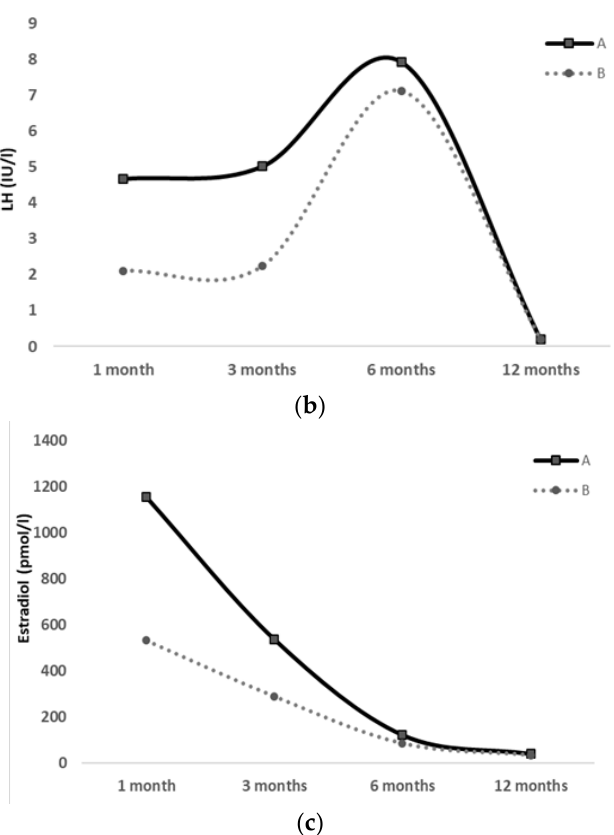
Figure 2. FSH ( a ), LH ( b ) and Estradiol ( c ) serum levels at 1, 3, 6 and 12 months of life in a pair of preterm twin girls; clinical pubertal signs were exhibited only by the first twin (twin A), whereas they were absent in the second twin (twin B) throughout the 12-month follow-up.